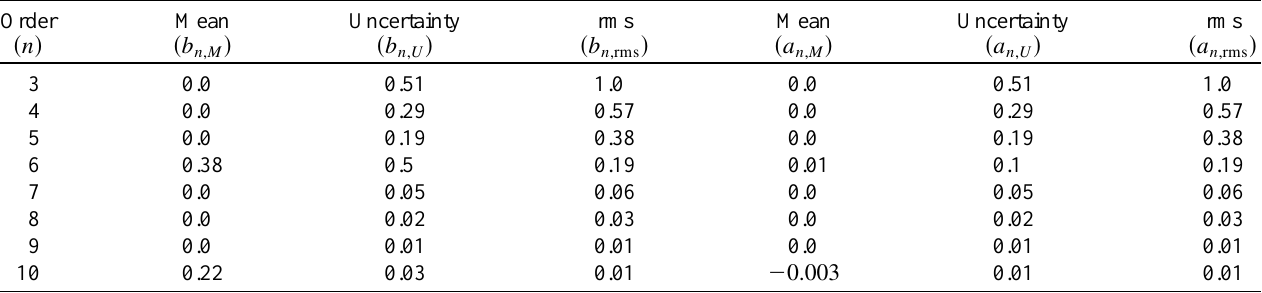
TABLE III. Harmonic multipole content in low- b quadrupoles (KEK design) [14,15]. The harmonic values are quoted in units of 10 2 4 of the main quadrupole field, for a reference radius r 0 (cid:1) 17 mm. Order Mean Uncertainty Mean